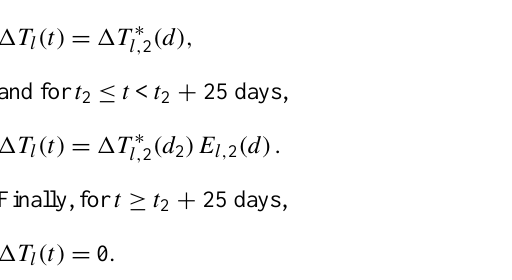
and B m are l,n l,n